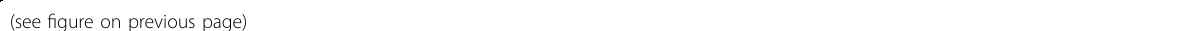
Fig. 3 Dual pharmacological inhibition of EZH2 and SQLE synergistically decreases the proliferation of HNSCC. A The combination index (CI) of EZH2 inhibitors and key enzyme inhibitors against cholesterol synthesis in CAL27 cells. N = 3 replicates. B The viability of CAL27 cells was detected by an MTT assay after EPZ6438 incubation and silencing of the corresponding gene with siRNAs. C The CI value of EPZ6438 combined with NB-598 or terbina fi ne in different cells. D The Bliss model was used to calculate the combination effect of EPZ6438 and terbina fi ne. E The enzyme activity of SQLE in the CAL27 cell with indicated treatment. N = 3 replicates, one-way ANOVA analysis was used to assess the statistical signi fi cance, **** p < 0.0001, EPZ vs vehicle; ### p < 0.001, TB vs vehicle; $$$$ p < 0.0001, ET vs EPZ. F Representative images and quantitative analysis of colony formation to indicate the potent synergistic anti-proliferative effect of EPZ6438 and terbina fi ne on HN6 and CAL27 cells. N = 3 replicates, one-way ANOVA analysis was used to assess the statistical signi fi cance, *** p < 0.001, **** p < 0.0001. G Real-time PCR detection to examine the expression of cholesterol synthesis-related genes in CAL27 and HN6 cell lines with different treatment. EPZ (single EPZ6438), TB (single terbina fi ne), ET (EPZ6438 + terbina fi ne), ATOR (atorvastatin), EA (EPZ6438 + atorvastatin), RO (Ro-488071), ER (EPZ6438 + Ro-488071), N = 3 replicates. H Immunoblotting assays to detect the protein levels of cholesterol synthesis-related genes in CAL27 and HN6 cell lines. I Flow cytometry examination to detect the cell cycle of CAL27 cells with different treatments for 48 h. J Flow cytometry examination to detect the apoptosis of CAL27 cells with different treatments for 72